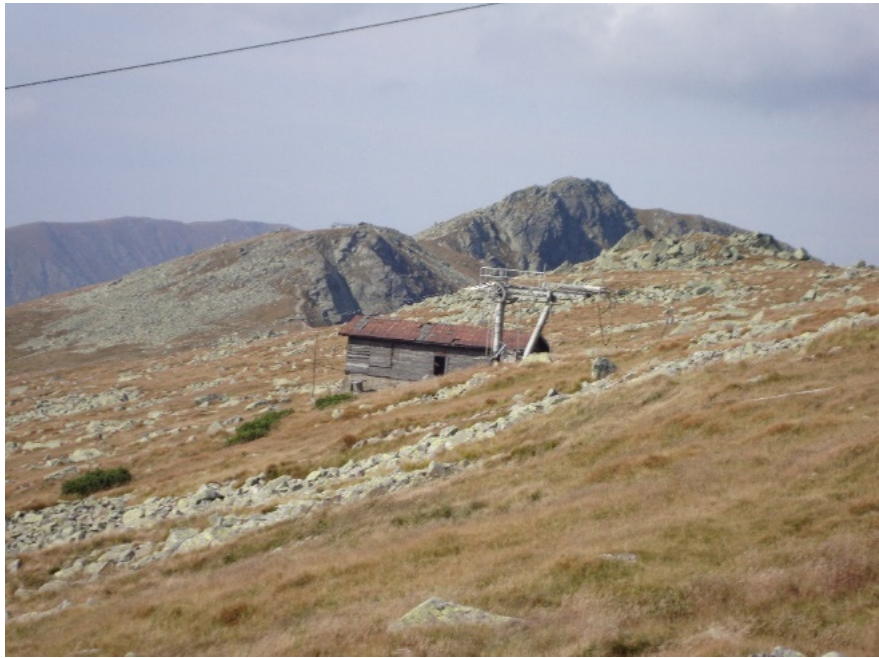
Figure 10. Habitat in the top part of Chopok massif, divided by the linear tourism superstructure (photo B. Gregorová).